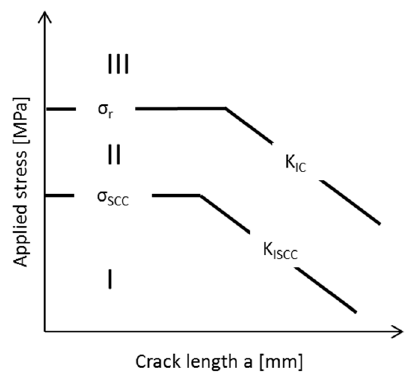
Figure 12. Influence of applied stress on the material behaviour in corrosive environment.